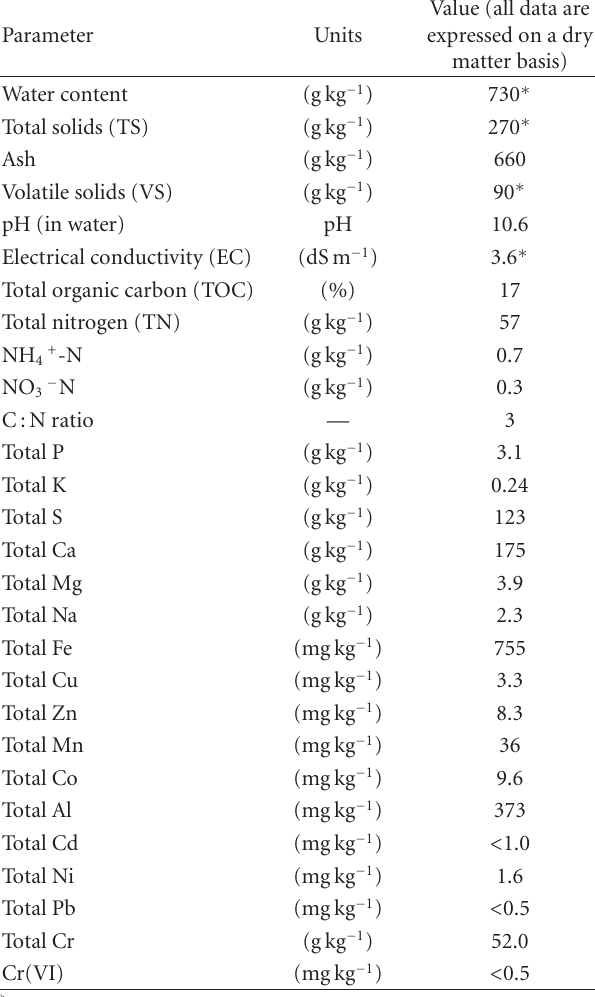
Table 2: Main physical and chemical characteristics of the two soils (M and